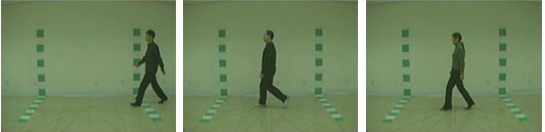
Fig. 5. Three images in CASIA Gait Database ( Dataset B) with view angle 90 ◦